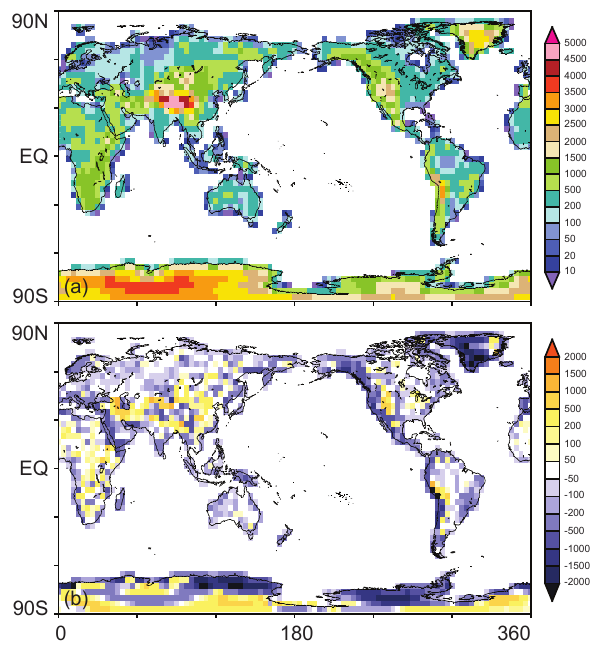
Fig. 2. Topography (m) conditions used in the experiments, (a) for local modern topography, (b) for the topography difference used to create the mid-Pliocene